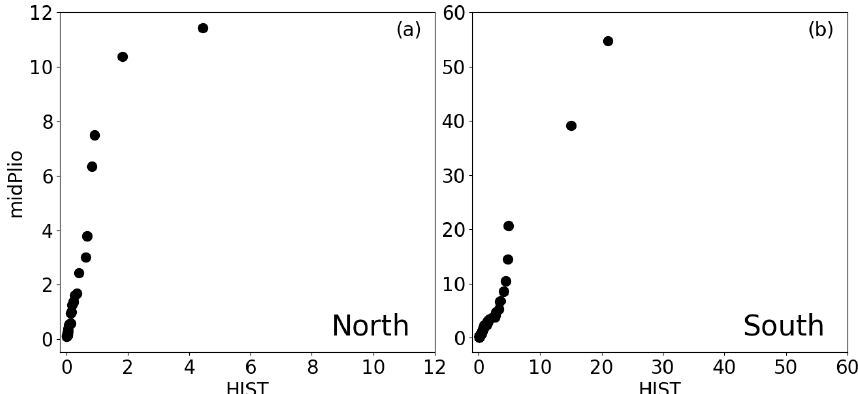
Figure 4. Percentile–percentile plots for daily winter rainfall (in mmd − 1 ) in WRF mP ( y axis; midPlio) against WRF hist ( x axis; HIST) as spatial means over (a) the northern box and (b) the southern box, as marked in Fig.